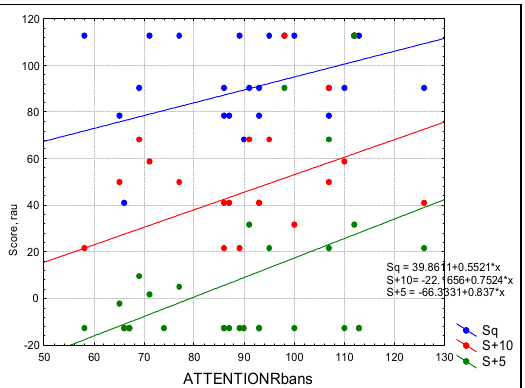
Figure 2. Scatterplot of audiological outcomes for sentences in three conditions: blue = quiet (Sq), red = SNR = +10 (S+10), and green = SNR+5 (S+5) as predicted by attention in the study sample (n = 30). Simple linear regression based on the RBANS score explained more than 46% of the variance for sentence recognition in noise.